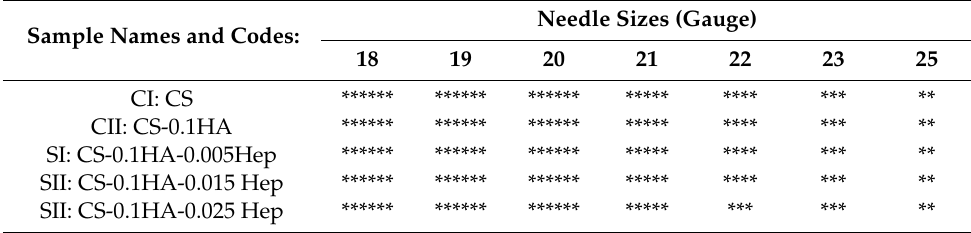
Table 2. Injectability rating of different hydrogel compositions 1 .